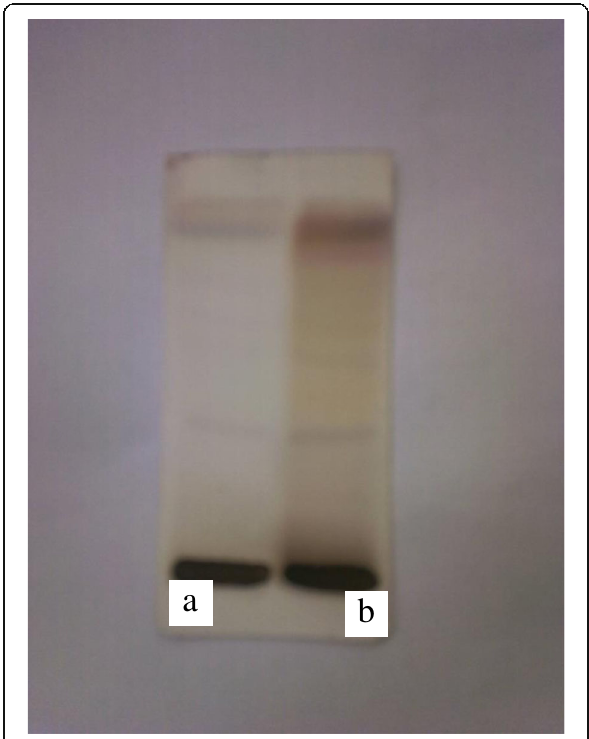
Fig. 2 Thin Layer Chromatography (TLC) fingerprinting profile of Methylene Chloride-Methanol (1:1) extracts of barks of Nauclea latifolia ( a ) and Annona senegalensis ( b